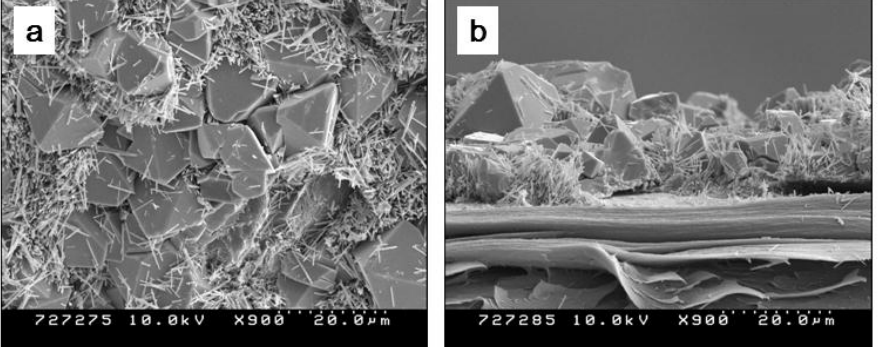
Figure 3. SEM images of CEZOHN without seeding at ( a ) surface and ( b ) cross